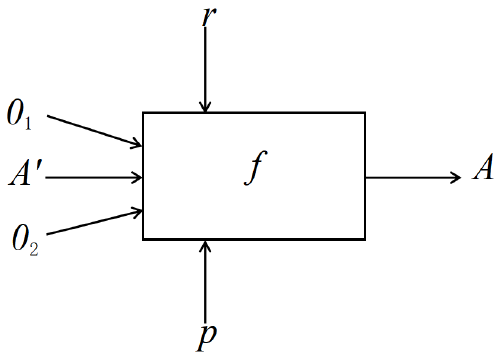
Figure 2. Ontology matching